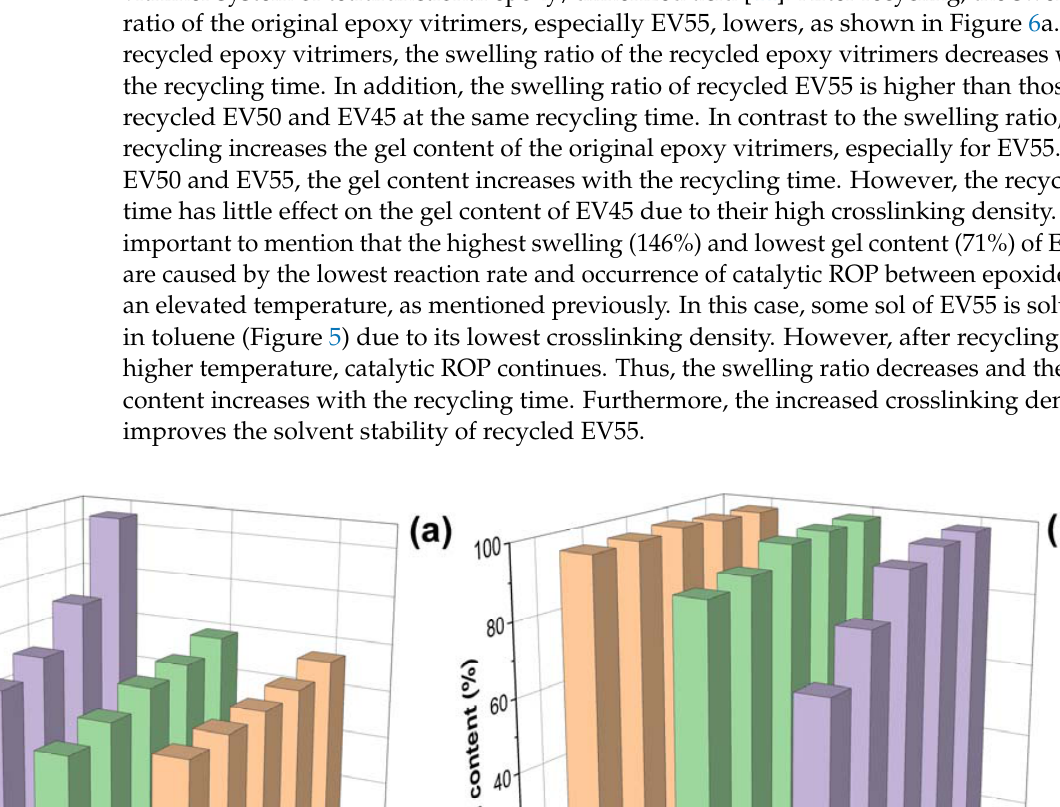
Figure 5. Solvent stability of the original and recycled epoxy vitrimers in toluene at room tempera ‐ ture after 48 h.